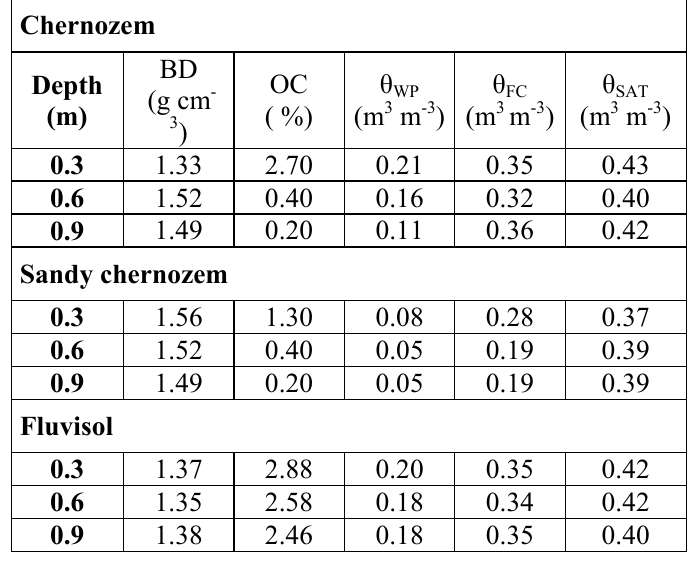
Table 3. Setting of the key CERES-Barley and CERES-Wheat input parameters based on the experimental